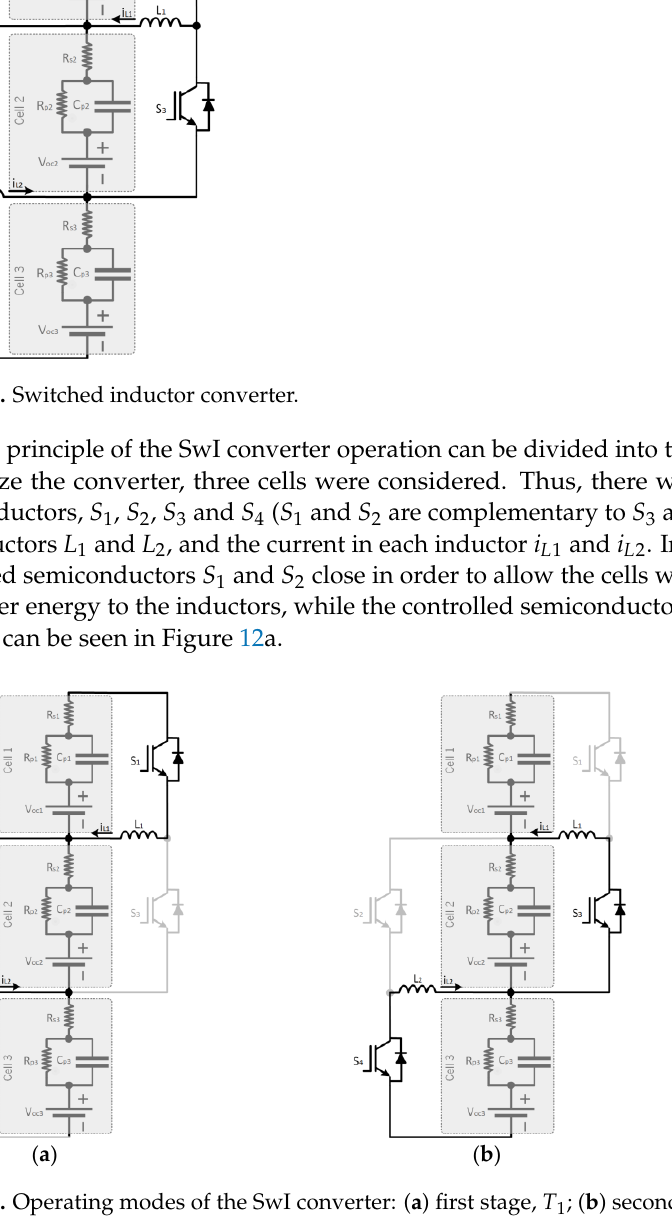
1 ; ( b ) second stage, T 2